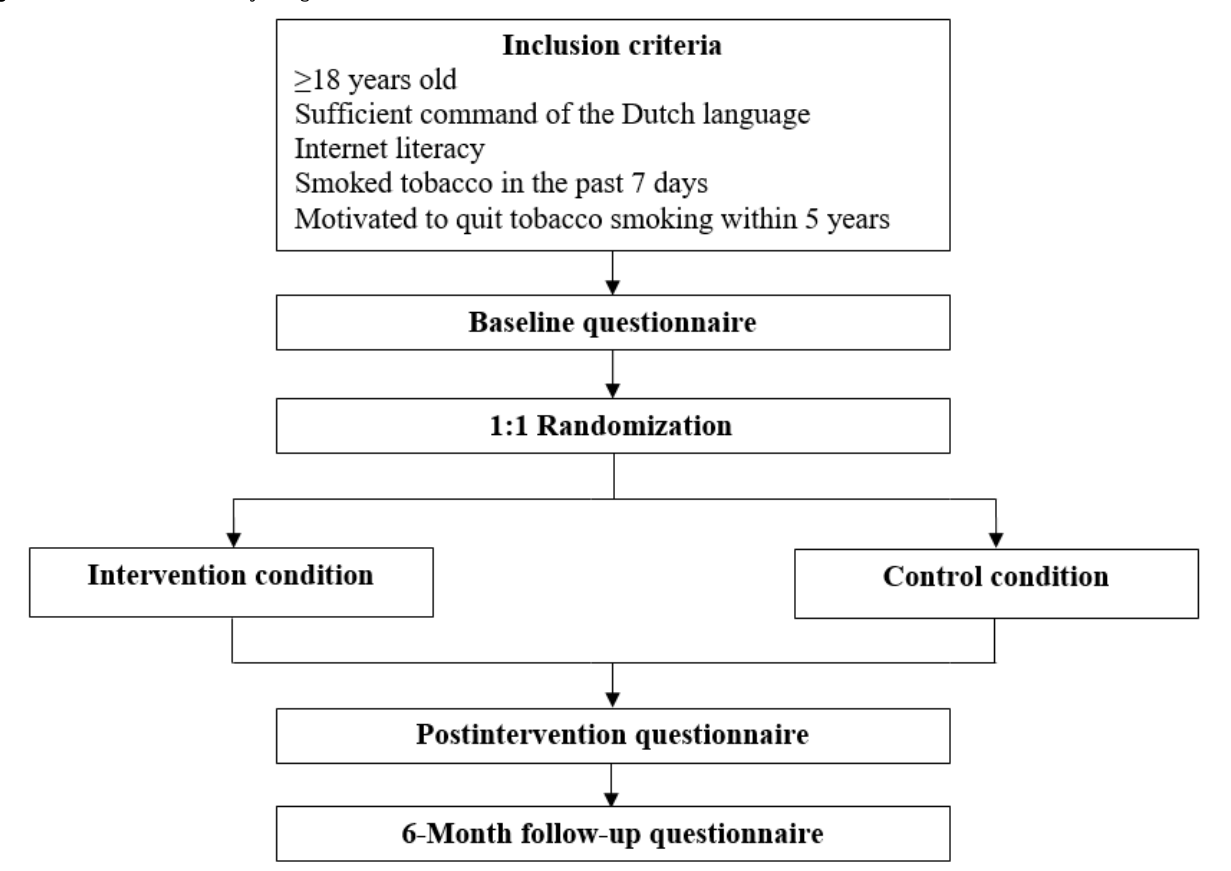
Figure 1. Flowchart of the study